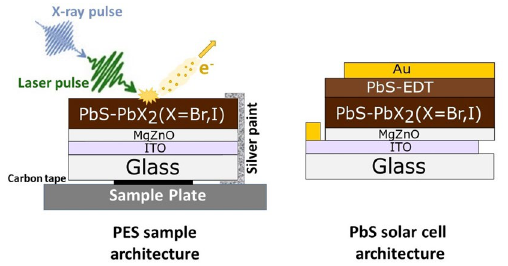
Figure 1. Architecture of QD samples used in photoelectron spectroscopy (left). The sample is connected to a metal sample plate through carbon tape and is grounded by applying silver paint. Architecture of a PbS-QD solar cell, which also includes a quantum dot layer with ethanedithiol ligand (EDT) and a gold contact